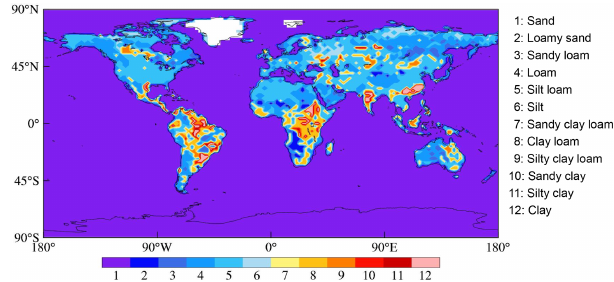
Figure 5. Global soil texture map based on the USDA